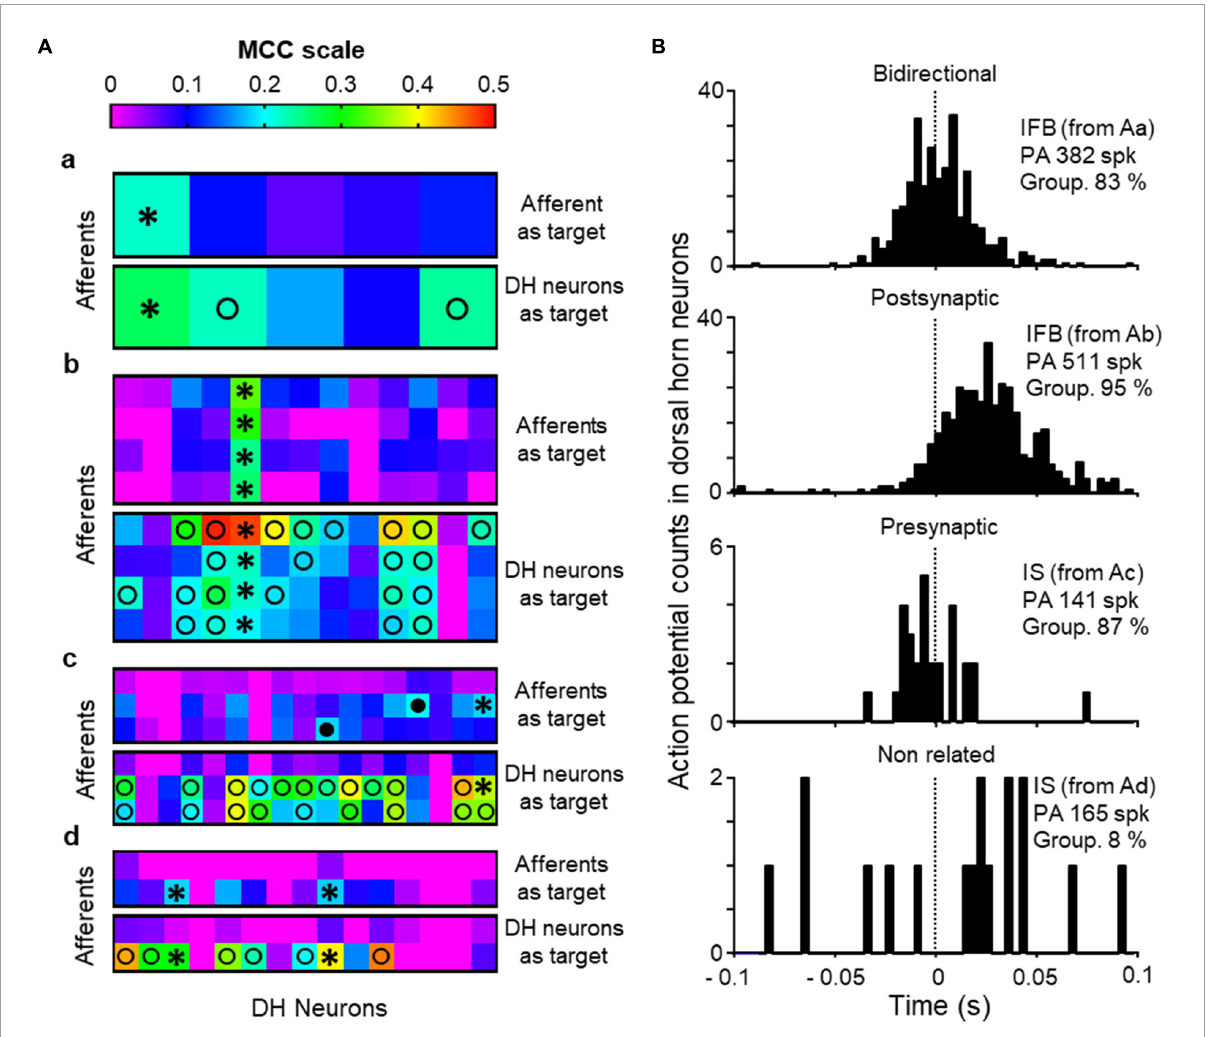
FIGURE6 Effective connectivity analysis. (A) Shows heat maps for effective connectivity as estimated with the MCC (color code at top). Values of MCC ≥ 0.18 were considered as putative monosynaptic connections. For each of the recordings performed (a–d) the upper map shows the likelihood of a dorsal horn (DH) neuron to be presynaptic to the afferent (afferent as target) and the bottom panel the likelihood of a DH neuron to be post-synaptic to the afferent (DH neuron as target). Black circles mark DH neurons considered as putative presynaptic to an afferent, open circles mark DH neurons putative post-synaptic to afferent neurons and * stand for bidirectional connections between DH neurons and afferents. (B) Correlograms between the firing of single afferents (time 0 and dotted line) and neurons showing different types of relation between them. The information in insets include the type of neuron, in parenthesis correspondence with recordings in panel (A) , number of action potentials of the primary afferent used to build the correlogram (PA) and the grouping of action potentials in population bursts for the